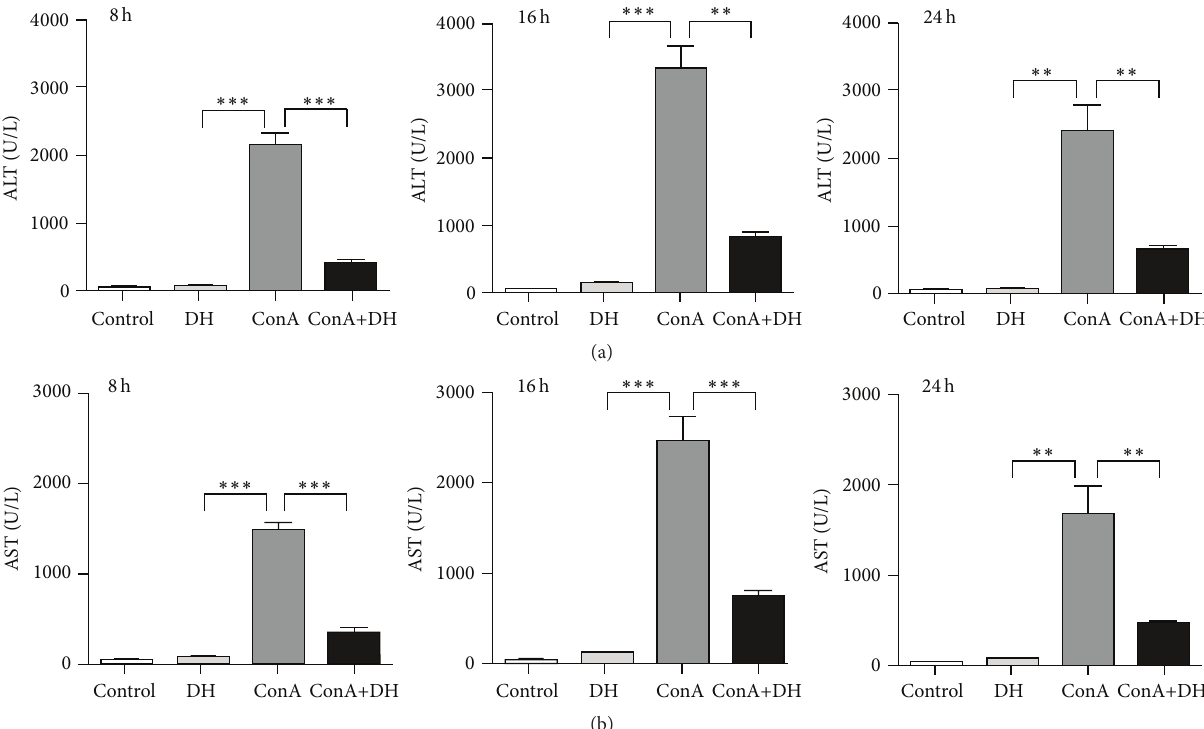
Figure 2: DH suppresses transaminase activity in ConA-induced hepatitis. Notes: female BALB/c mice were induced by intraperitoneal injection with DH (20 mg/kg of body weight) at 2 h before the injection of a sublethal dose of Concanavalin A (15mg/kg of body weight) via the tail vein. Serum transaminase ALT (a) and AST (b) levels were determined 8, 16, and 24 hours after Concanavalin A injection. Data is expressed as mean ± SD ( 𝑛 = 3 ; ∗∗ 𝑃 < 0.05 and ∗∗∗ 𝑃 < 0.001 ). ALT: alanine transaminase; AST: aspartate transaminase.